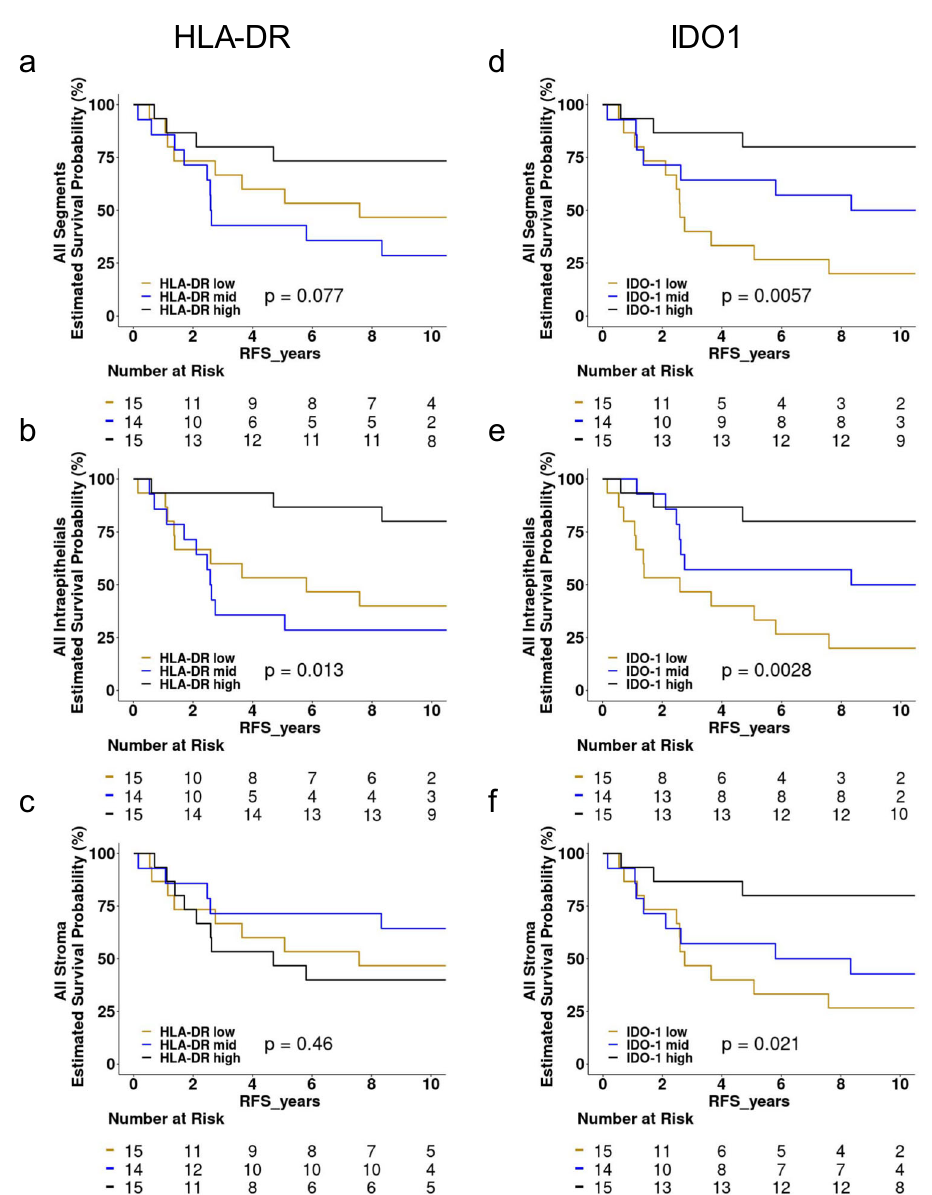
Fig. 2 | Kaplan – Meier analysis of recurrence as a function of HLA-DR or IDO1 abundance in All Intraepithelial and All Stromal segments. Tumor-average protein counts were used to stratify samples into tertiles (high=black, mid=blue, low=orange) based on the abundance of HLA-DR or IDO1. Kaplan – Meier analysis wascarriedoutusingproteinabundanceandtimetoeventascontinuousvariables. Log-rank p -valuesaregiven,withthenumberofpatients “ atrisk ” shownbeloweach curve.SourcedataaregiveninSupplementaryData2.KManalysisofrecurrenceas